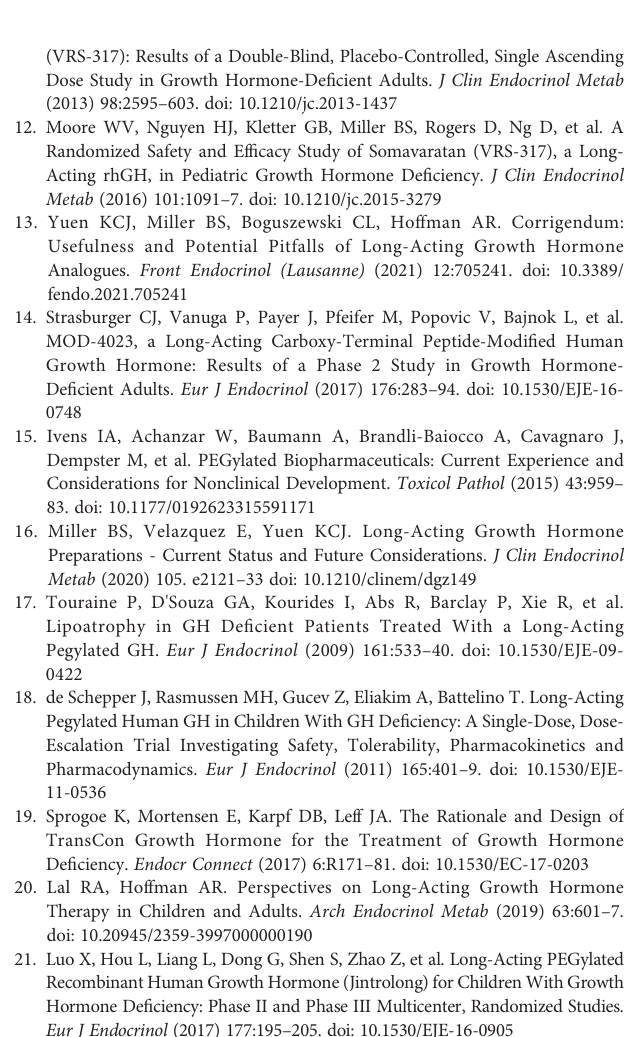
Supplementary Figure 3 | Subcellular imaging of cynomolgus monkeys CP epithelium with 52-week administration of Jintrolong and after 104-/157- week recovery. (A) . Representative image for excipient control group. (B) . Area in monkey #7883(3 mg/kg/week Jintrolong group with 52 weeks administration) show minor subcellular structure change. (C) . 3 mg/kg/week Jintrolong group with 52 weeks administration and 104 weeks recovery. (D) . 3 mg/kg/week Jintrolong group with 52 weeks administration and 157 weeks recovery. Left arrow with TJ in Figure S3B indicate intact tight junction. Arrow with ERD in Figure S3B indicate rough endoplasmic reticulum dilation. The lower arrow with MS in Figure S3B indicate minor mitochondrial swelling with bigger size, lighter color and less cristae. Arrow with LMV in Figure S3B indicate less microvilli with enlarged terminal